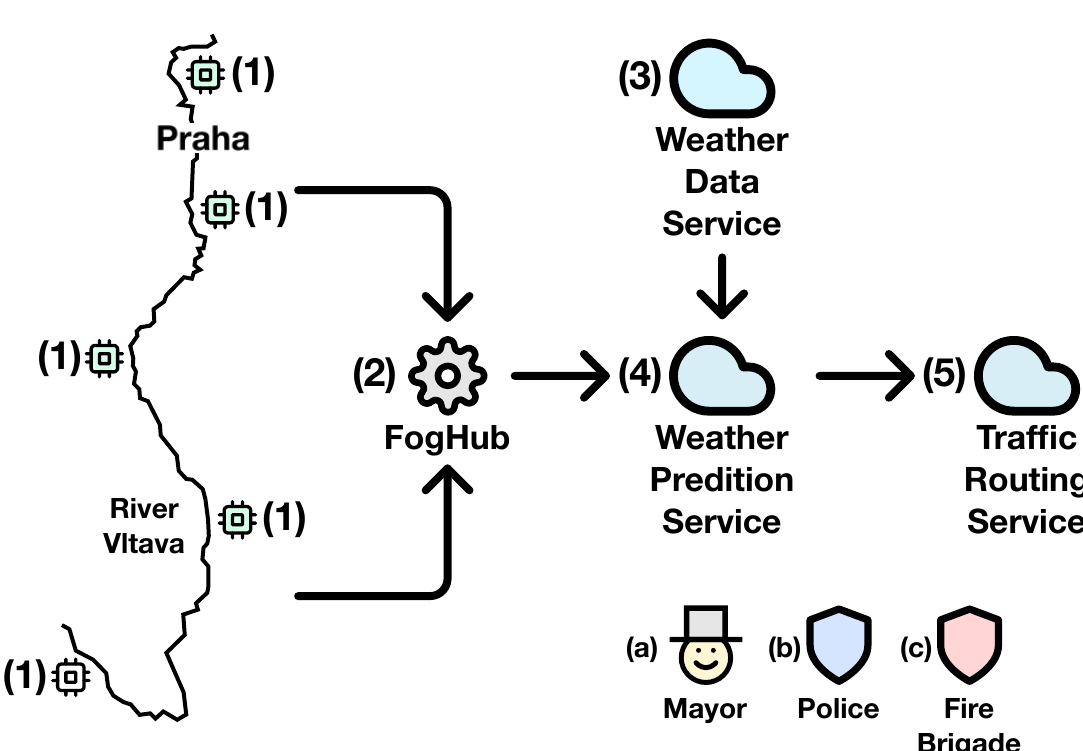
Figure 21. Flood control use